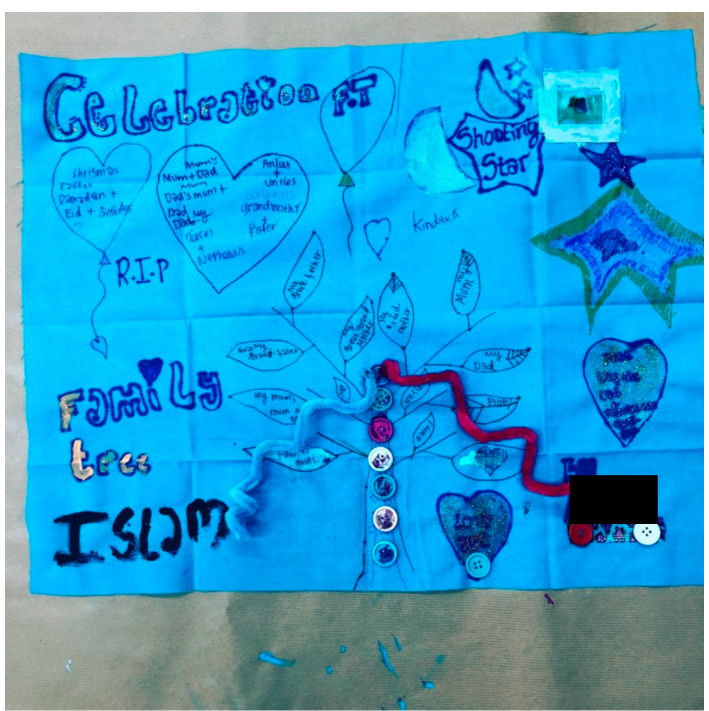
Figure 6. Expressive representation of religion, culture and belonging. Created by a South East London girl. RMIT University Human Ethics Clearance Number